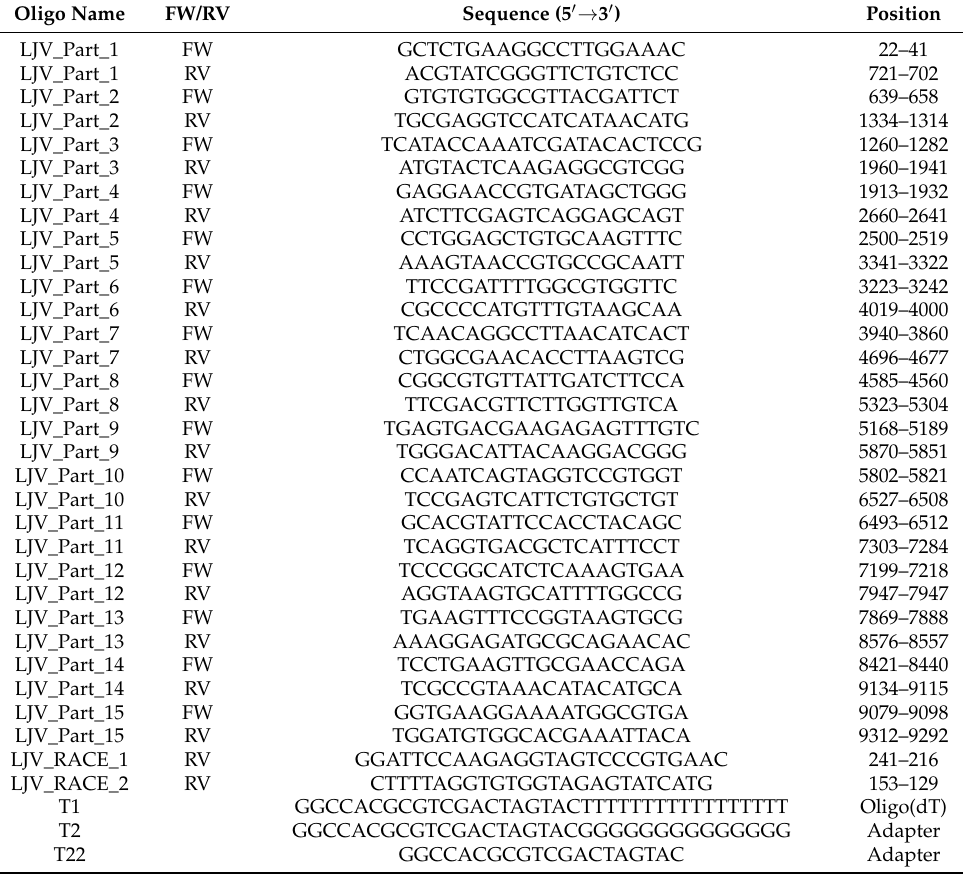
Table 1. Oligonucleotides used in this